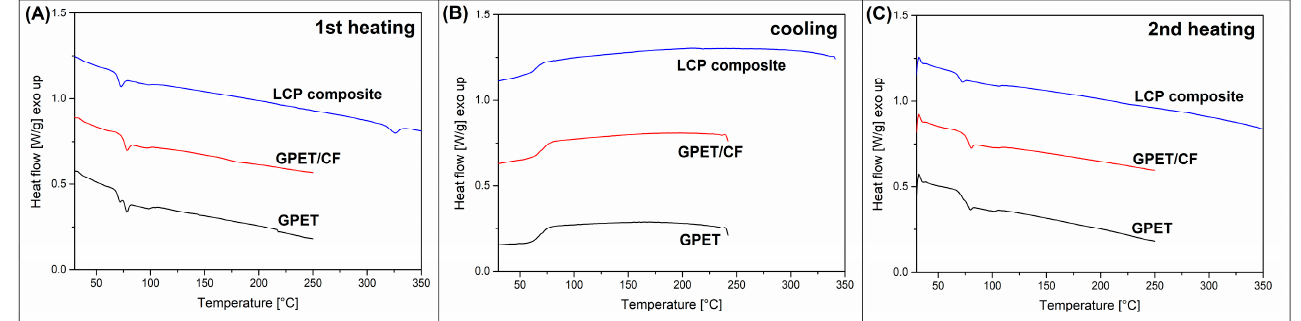
Figure 3. DSC thermograms for pure GPET, GPET/CF, and srLCP composite: ( A ) 1st heating, ( B ) cooling, and ( C ) 2nd heating stage.